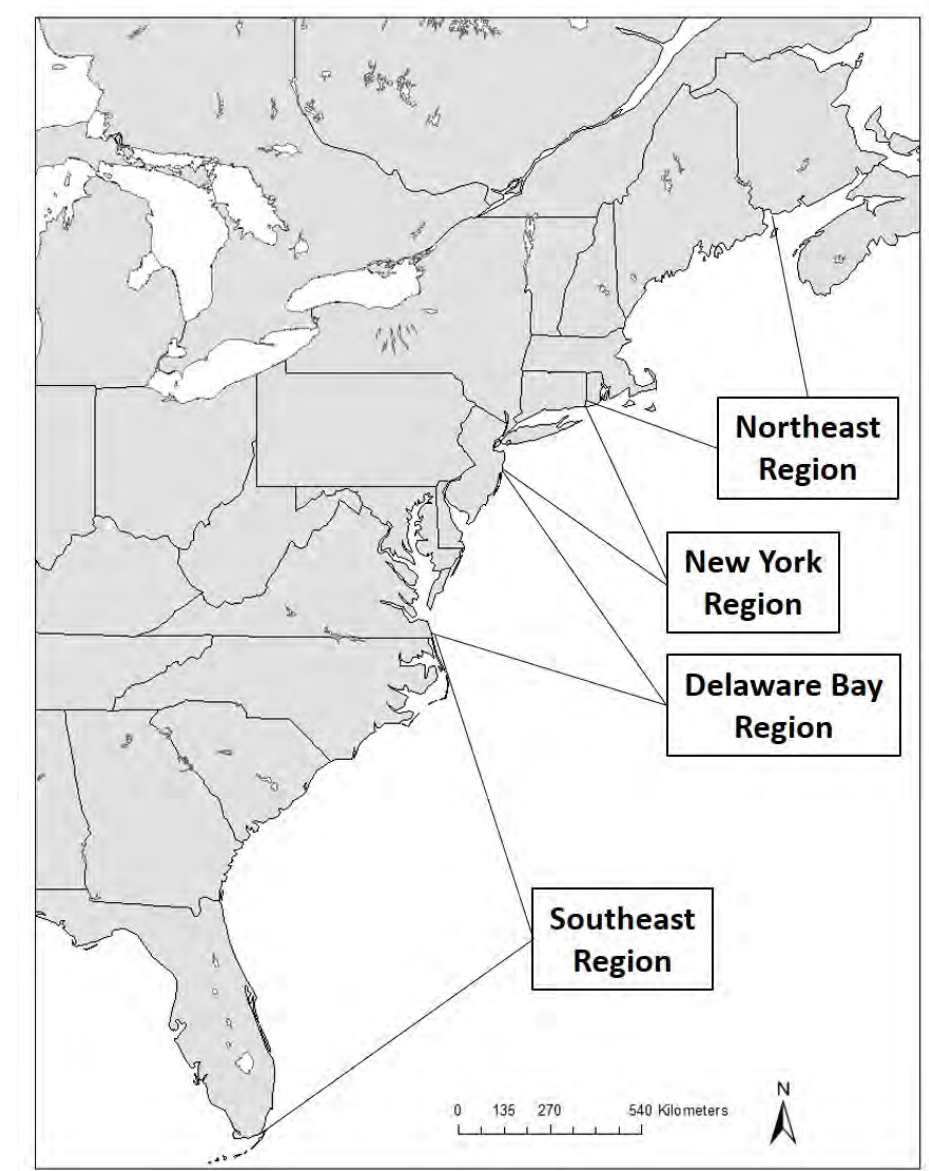
Figure 1. Map of the Atlantic coast showing the regions for horseshoe crab